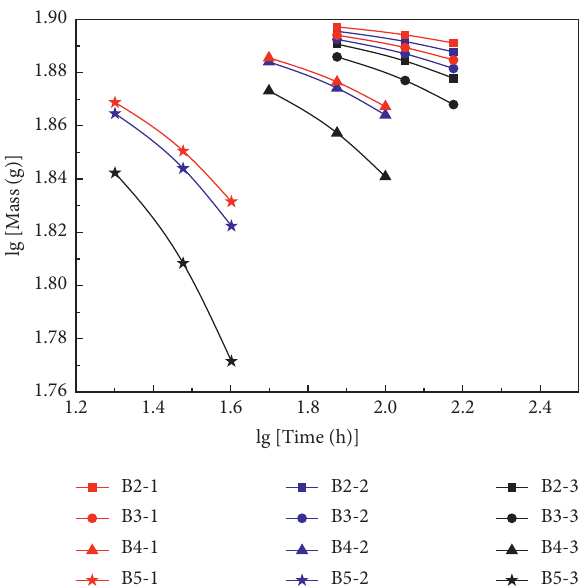
Figure 7: Time-residual mass curve of specimens.